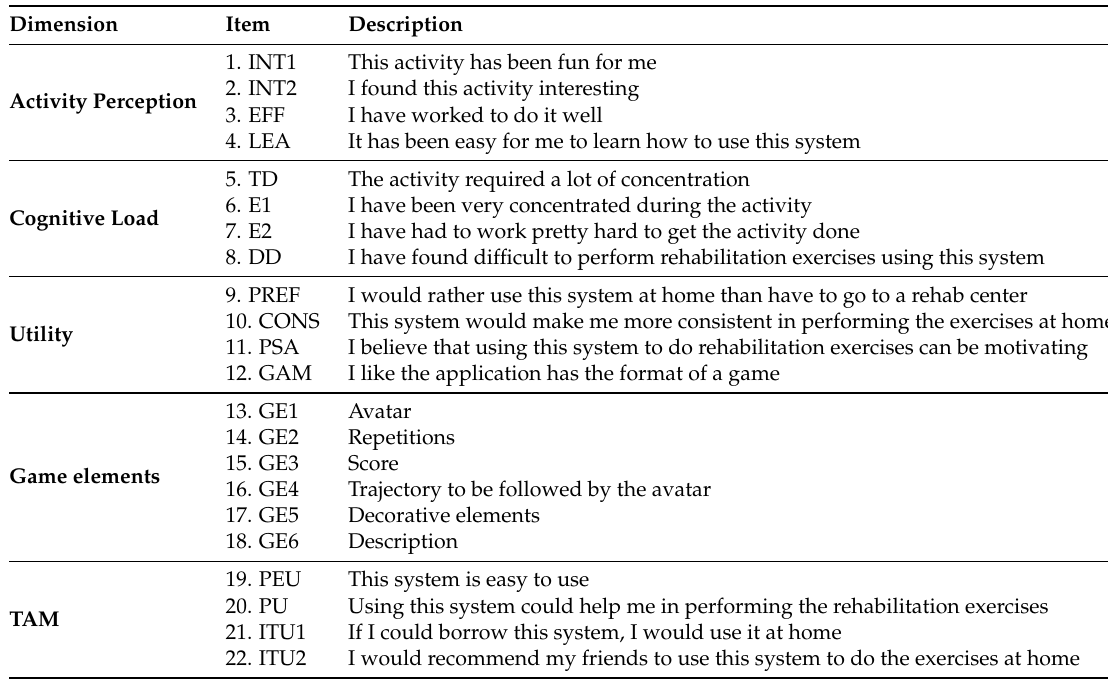
Table A1. Textual description of the items evaluated by